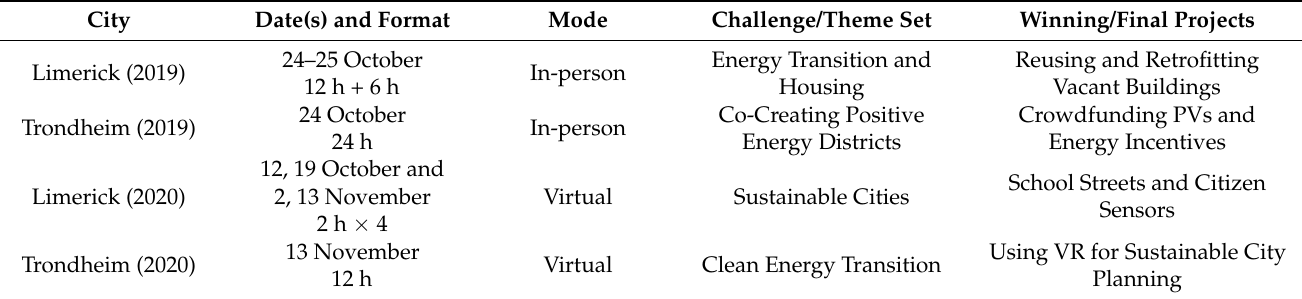
Table 2. Overview of +CityxChange Climathon Events (2019–2020).